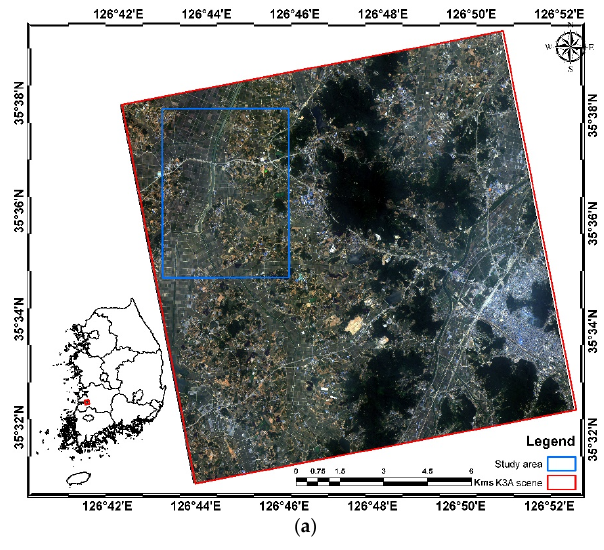
Figure 1. Overall process adopted in this study where land cover classification of Korea Multi ‐ Purpose Satellite (KOMPSAT) ‐ 3A image was done using four supervised methods i.e. Mahalanobis Distance (MahD), Minimum Distance (MinD), Maximum Likelihood (ML) and Support Vector Machine